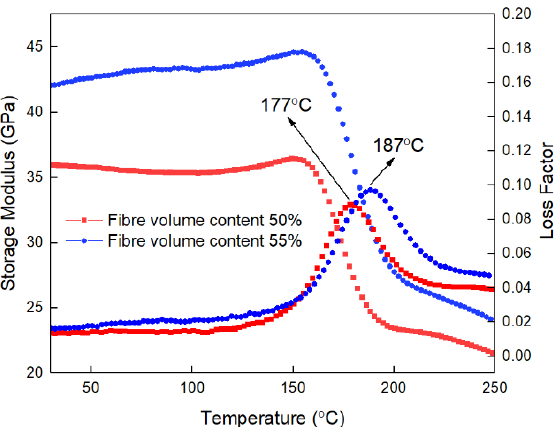
Figure 11. DMA curves for laminates with different CF volume fractions.